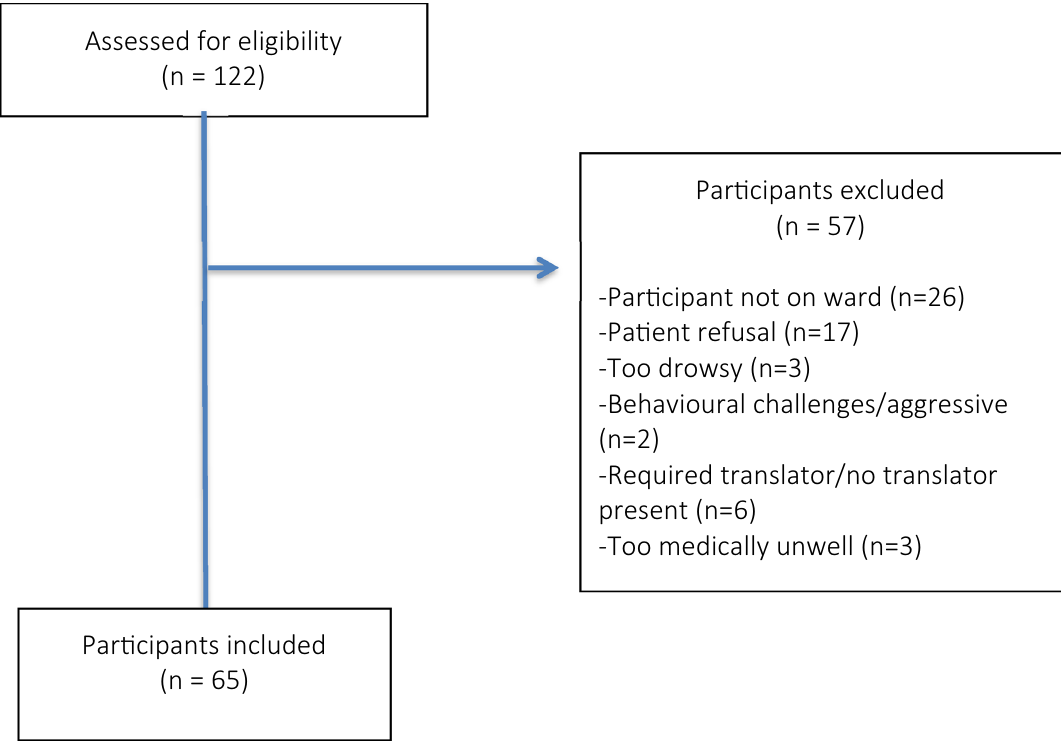
Figure 1. Flow diagram of participants through the